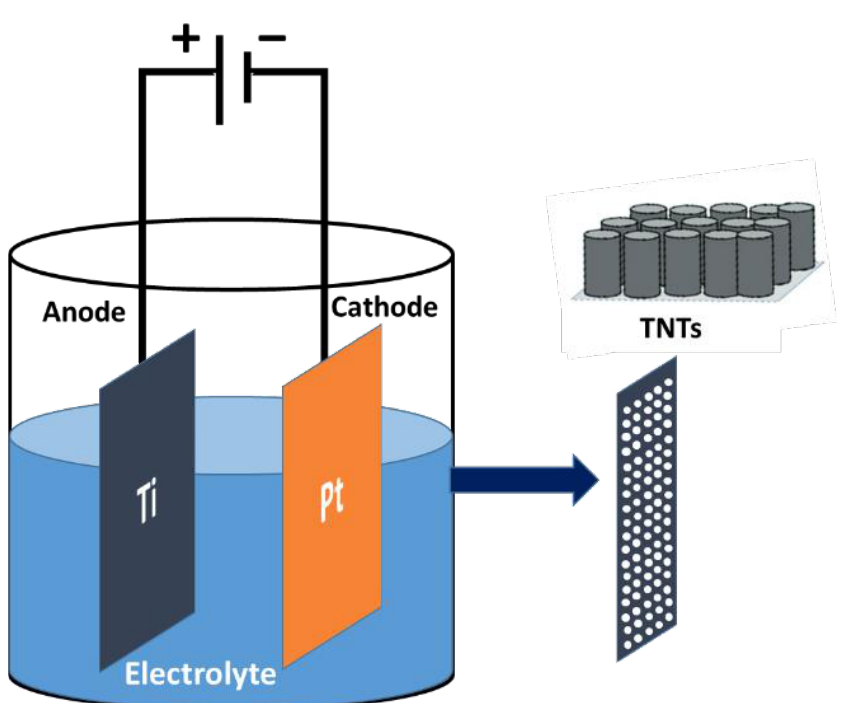
Figure 5. Synthesis of TNTs via electrochemical anodization.